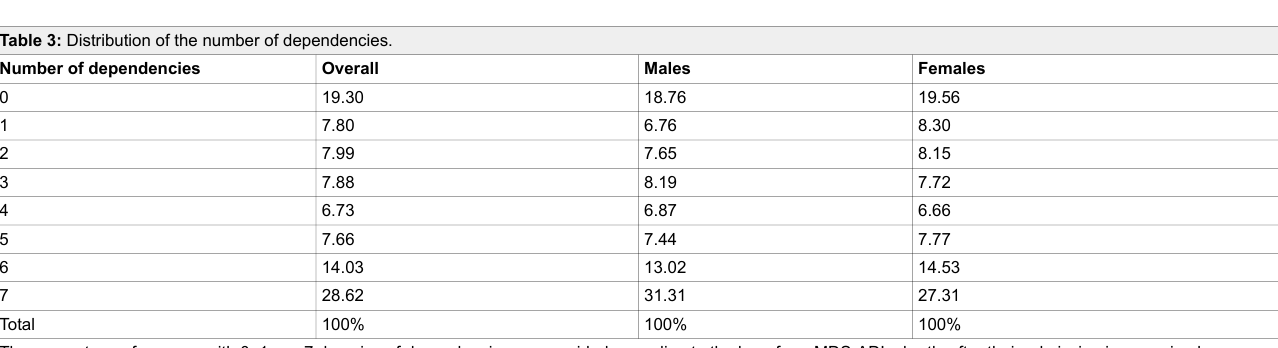
Table 3: Distribution of the number of dependencies.